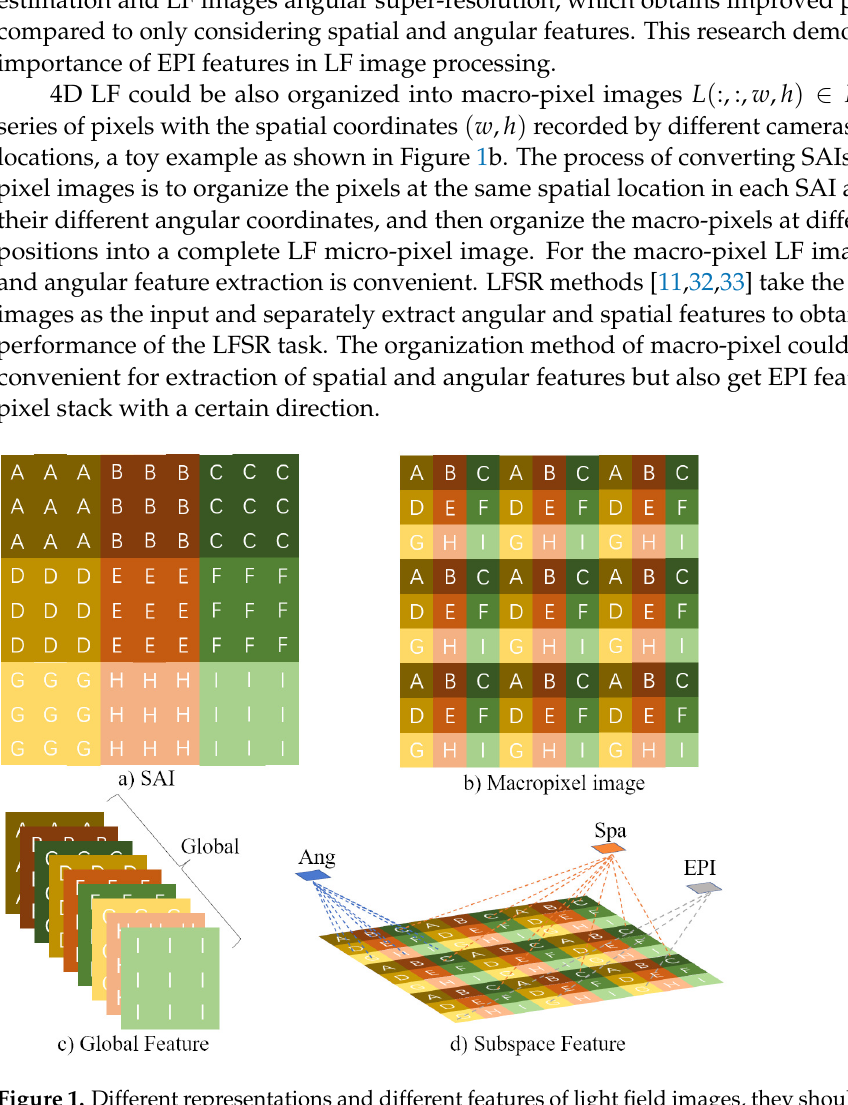
Figure 1. Different representations and different features of light field images, they should be listed as: ( a ) Light Field Sub-aperture image. ( b ) Macro-pixel Light Field Image. ( c ) Global Feature ( d ) Spatial, Angular and EPI